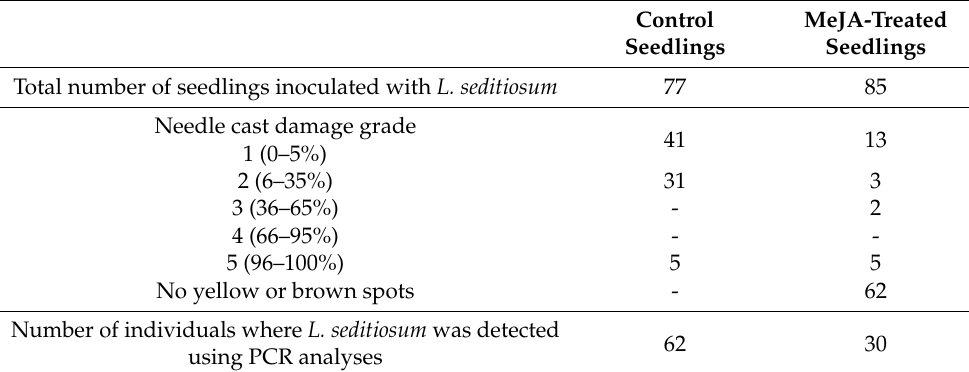
Control MeJA-Treated Seedlings Seedlings